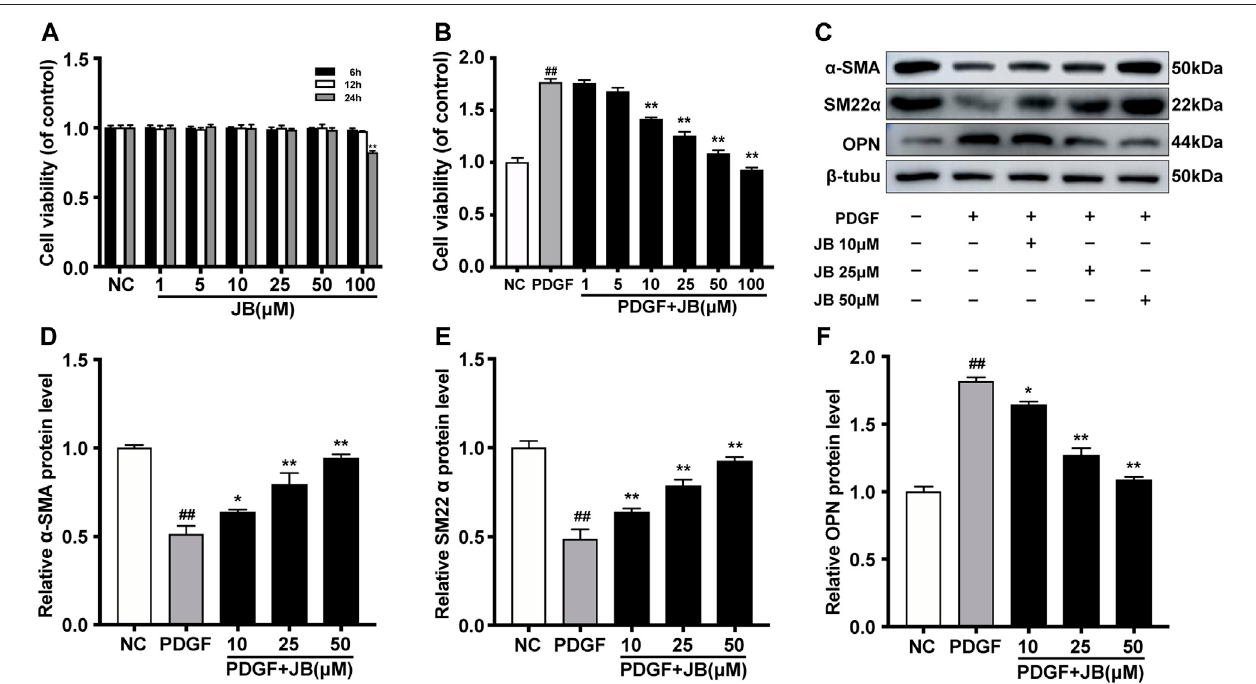
FIGURE 3 | JB abolished PDGF-BB induced dedifferentiation of VSMCs. (A) Effects of different concentrations of JB treatment on the vitality of VSMCs according to CCK-8 assay. (B) Effects of JB treatment on the viability of VSMCs induced by PDGF-BB. (C) Western blotting analysis of α -SMA, SM22 α and OPN in VSMCs stimulated by PDGF-BB and pretreated with different concentrations of JB. (D – F) Quanti fi cation of α -SMA (D) , SM22 α (E) , OPN (F) protein expression levels between groups. Data are expressed as mean ± S.D. ## p < 0.01 vs. Control. * p < 0.05 and ** p < 0.01 vs. PDGF-BB group. n (cid:1)